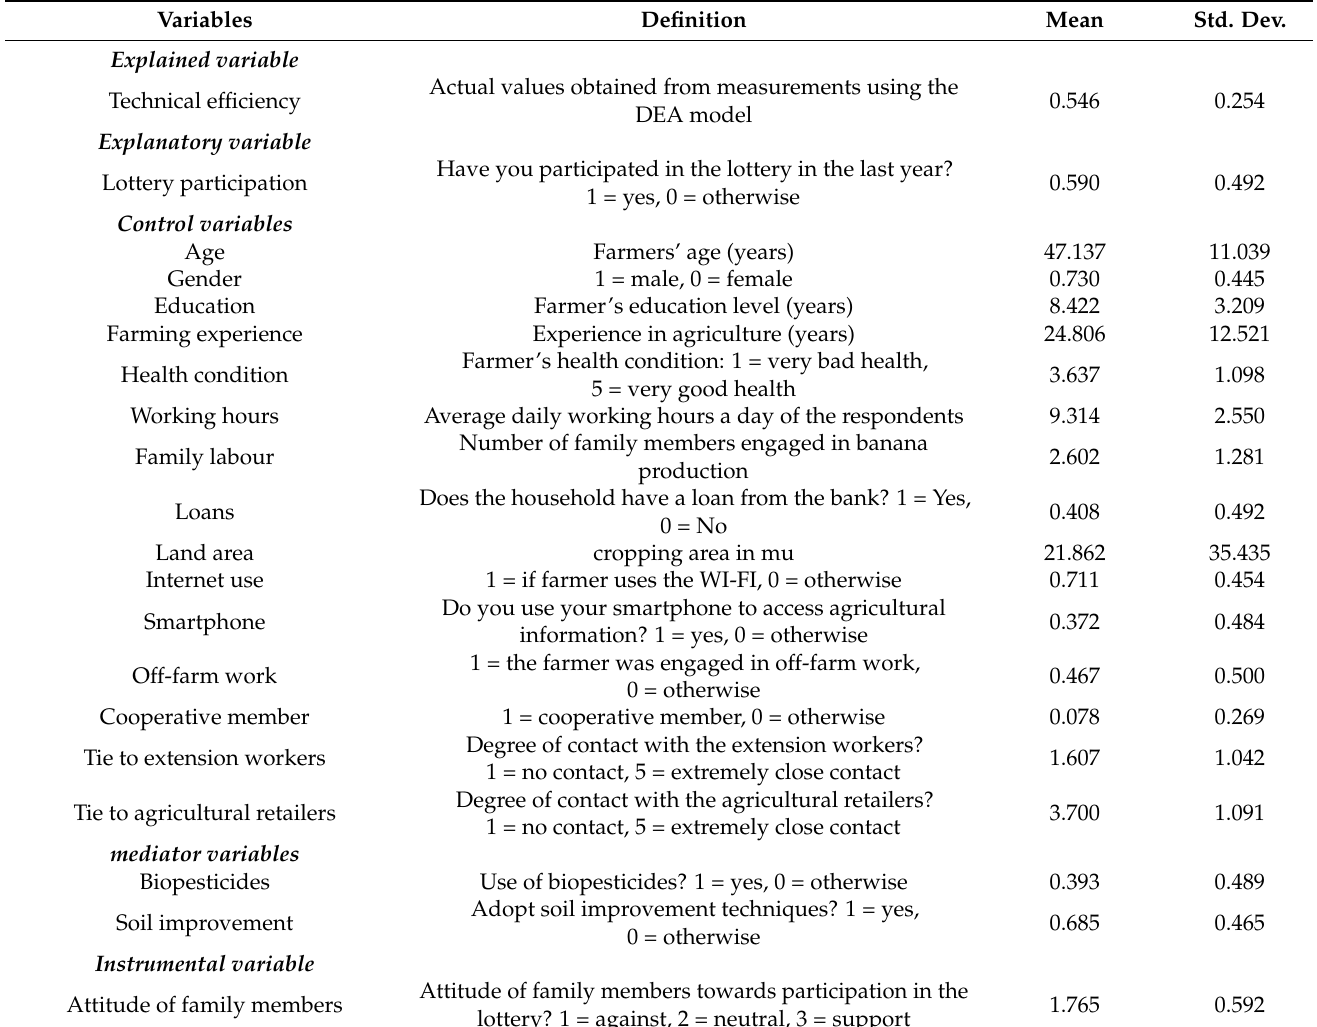
Table 3. Variable definitions and descriptive